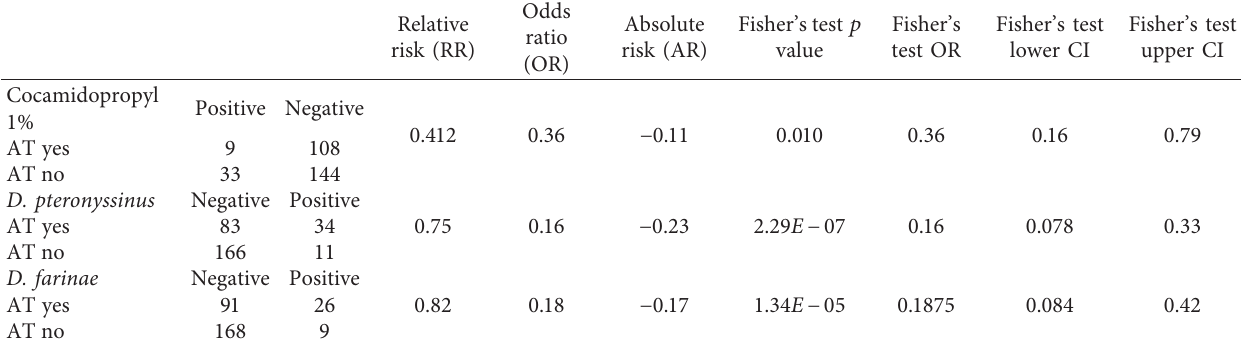
Table 9: Risk assessment for the presence of